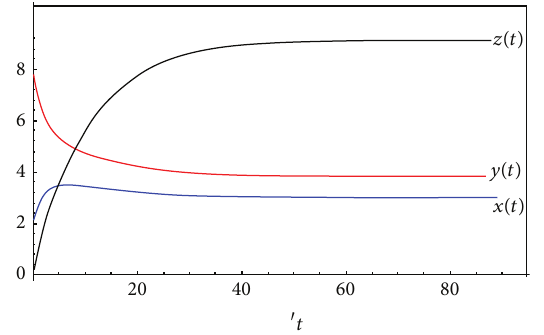
Figure 4: 𝛽 0 = 0.9 , 𝜆 0 = 0.1 , 𝛼 0 = 0.5 , 𝛾 0 = 0.03 , 𝜃 = 0.6 , 𝜇 = 0.1 , and 𝑅 0 = 3.46 .